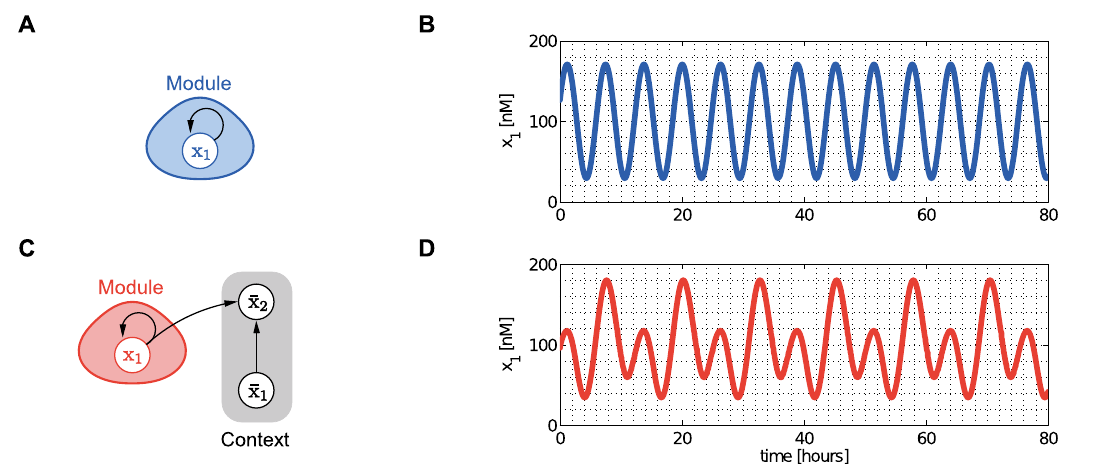
Figure 2. The context (downstream system) affects the behavior of the module (upstream system). (A) The module in isolation. (B) The module in isolation displays sustained oscillations. (C) The module connected to its context. (D) Upon interconnection with its context, the dynamics of the module change due to the retroactivity s from its context, since some of the molecules of x 1 are involved in binding reactions at node (cid:2) xx 2 . As a result, those molecules are not available for reactions in the module, and the output of the module is severely changed. For details on the system and parameters, see Supporting Text S1.